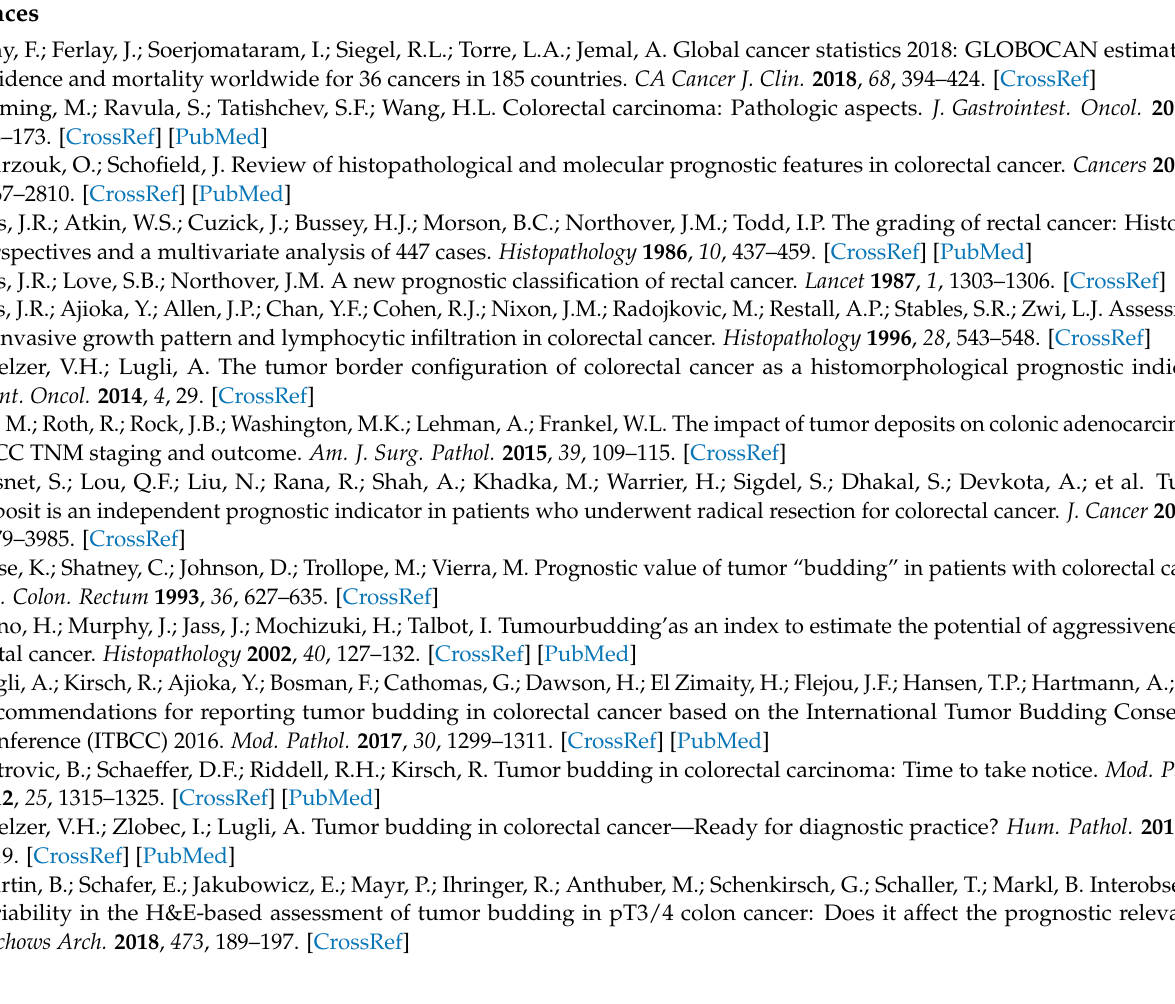
ers depending on the SARIFA grading in group C., Table S1: Clinicopathological characteristics of group C., Table S2: Spearman Correlation of morphological biomarkers., Table S3. Subgroup analyses of SARIFA in UICC stage II vs.